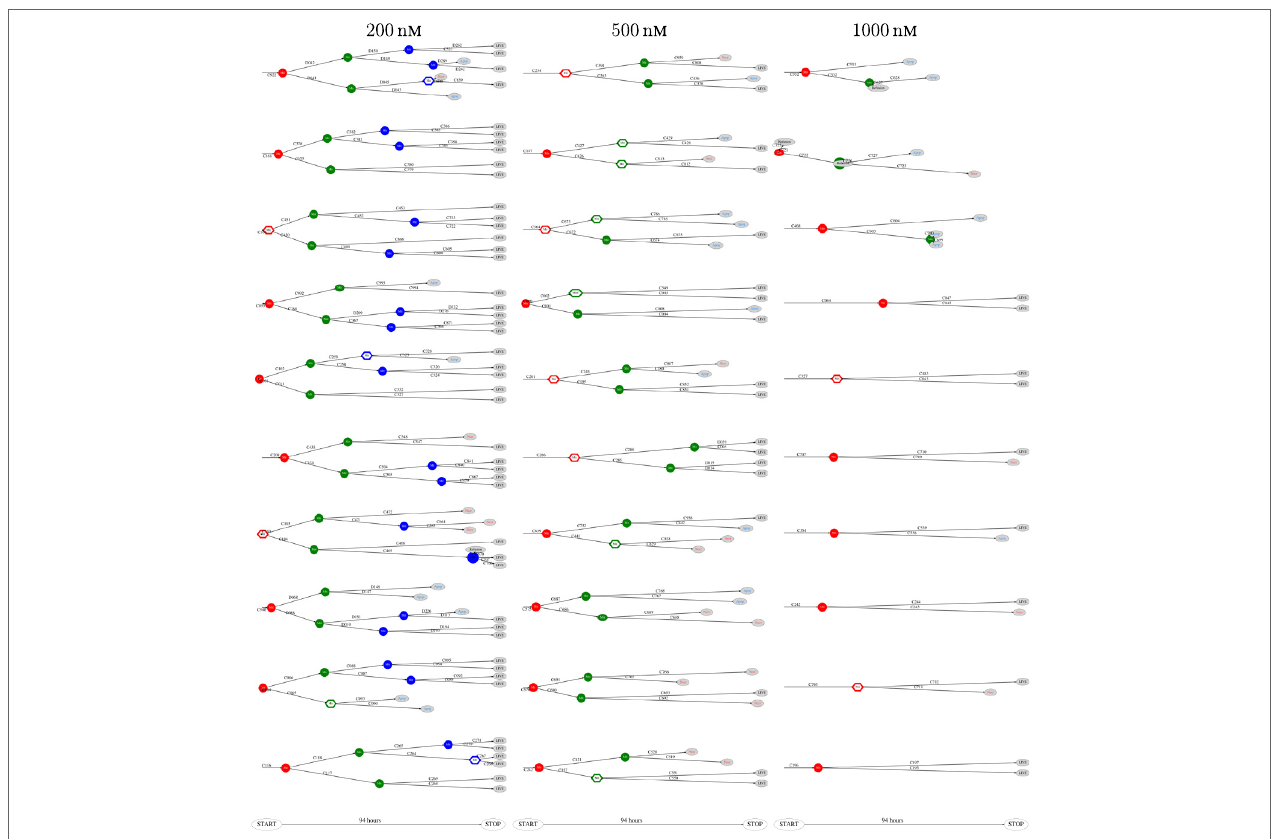
FigUre 7 | Pedigree tree number 46–55 (“median”) for cells exposed to 200, 500, and 1,000 nM (respectively from left to